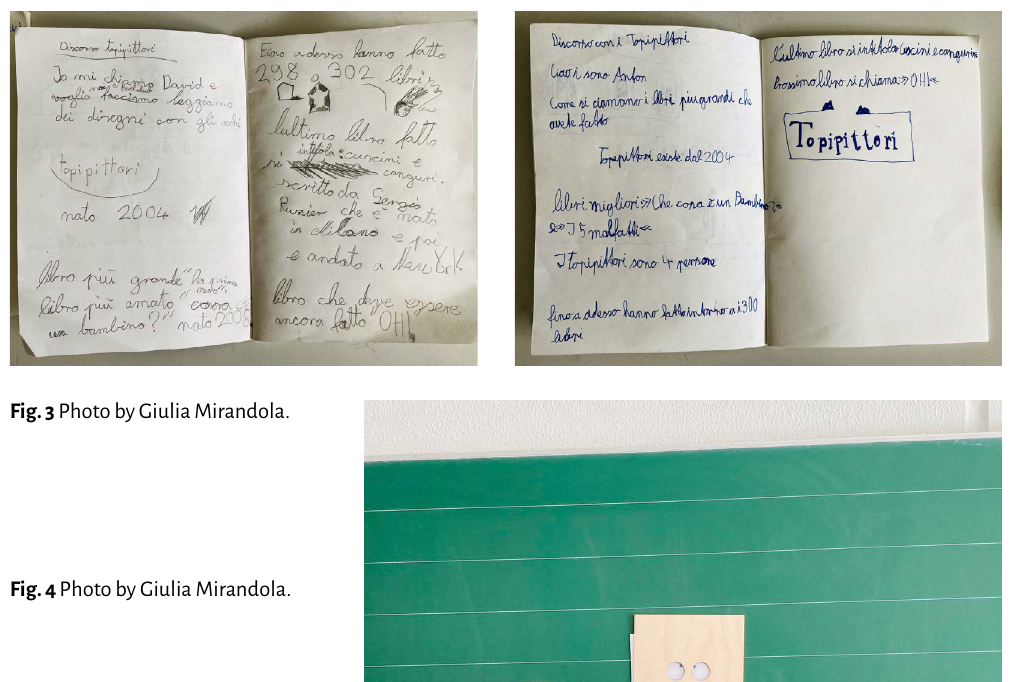
Fig. 4 Photo by Giulia